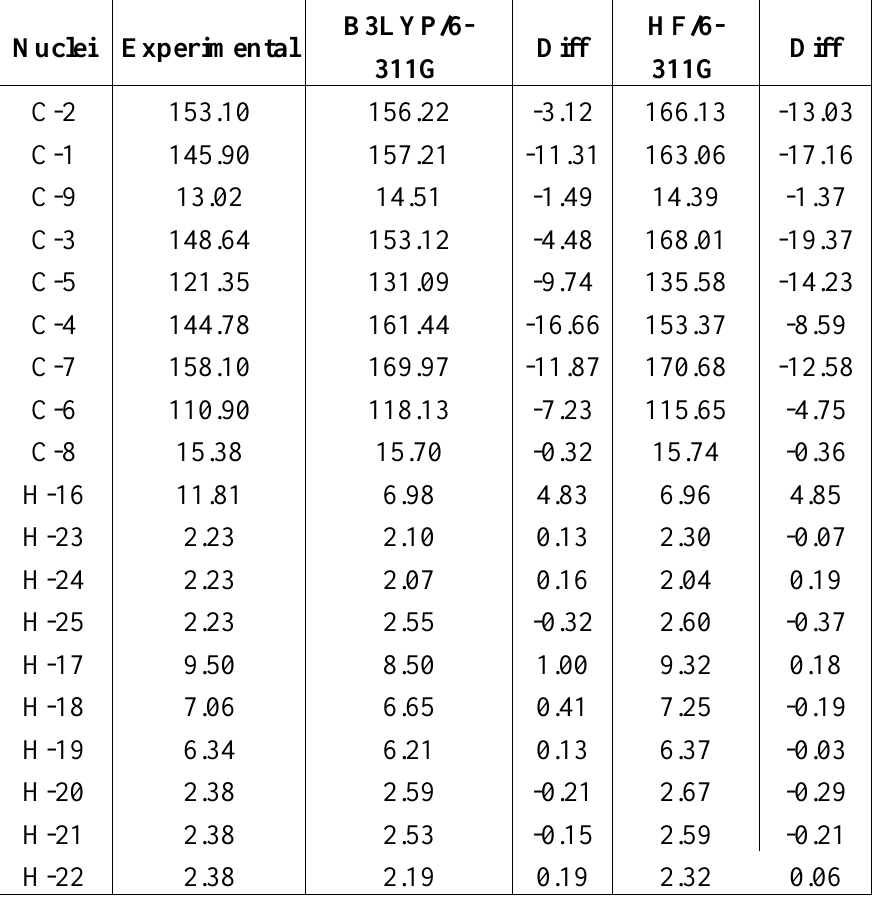
Table 1 . Comparision between experimental and calculated chemical shifts (ppm) of 2a